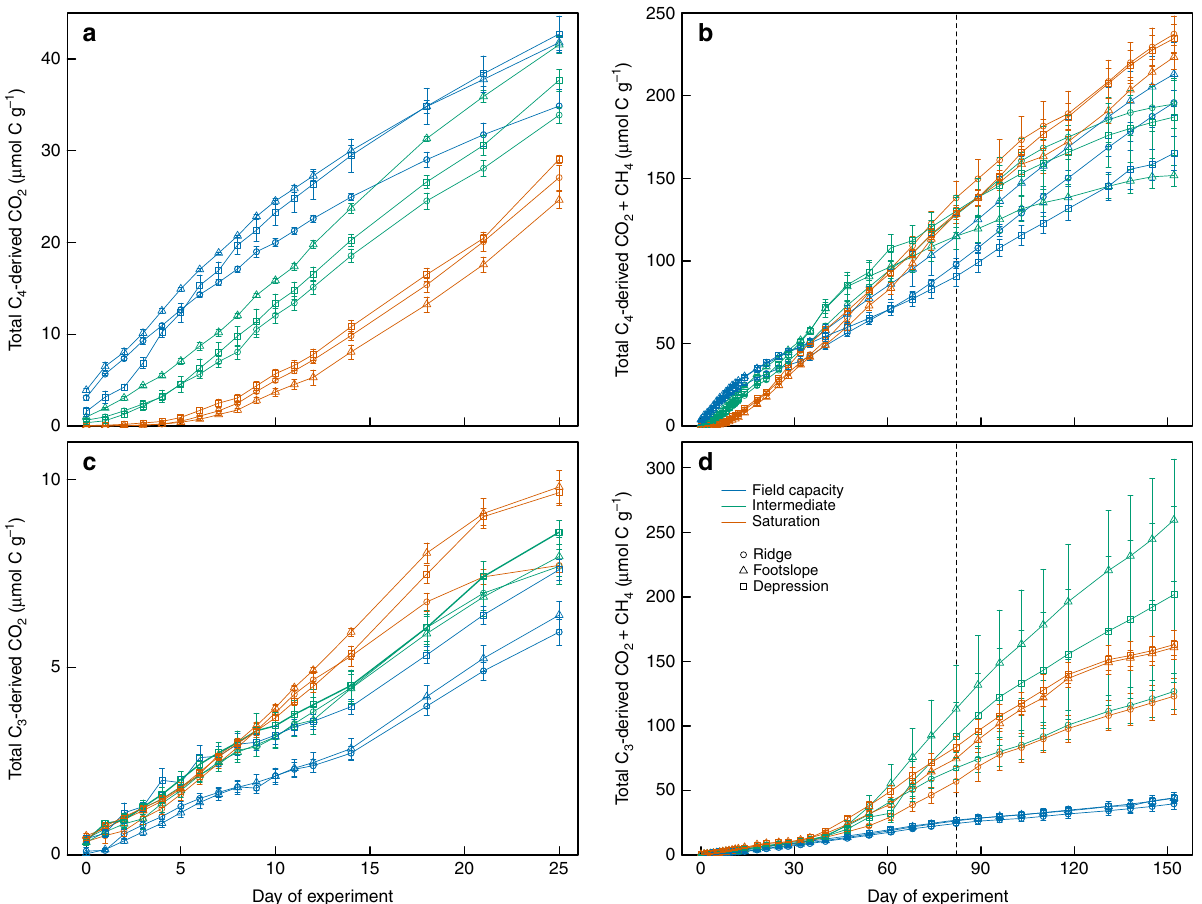
Fig. 3 Cumulative mineralization of different C sources in three Mollisols incubated under moisture levels at and above fi eld capacity. a , c Short-term cumulative mineralization of C 4 -derived C ( a ) and C 3 -derived C ( c ) respired as CO 2 ; b , d long-term cumulative mineralization of C 4 -derived C ( b ) and C 3 - derived C ( d ) respired as CO 2 and CH 4 . The vertical dashed line indicates when gradual drainage was initiated in the saturated soils. The error bars